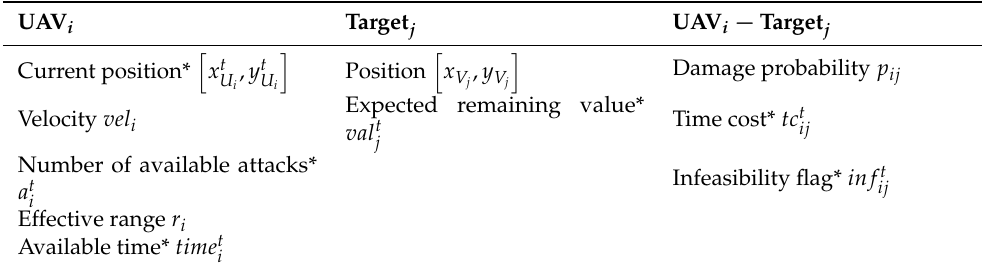
Table 1. Variables used to represent the state